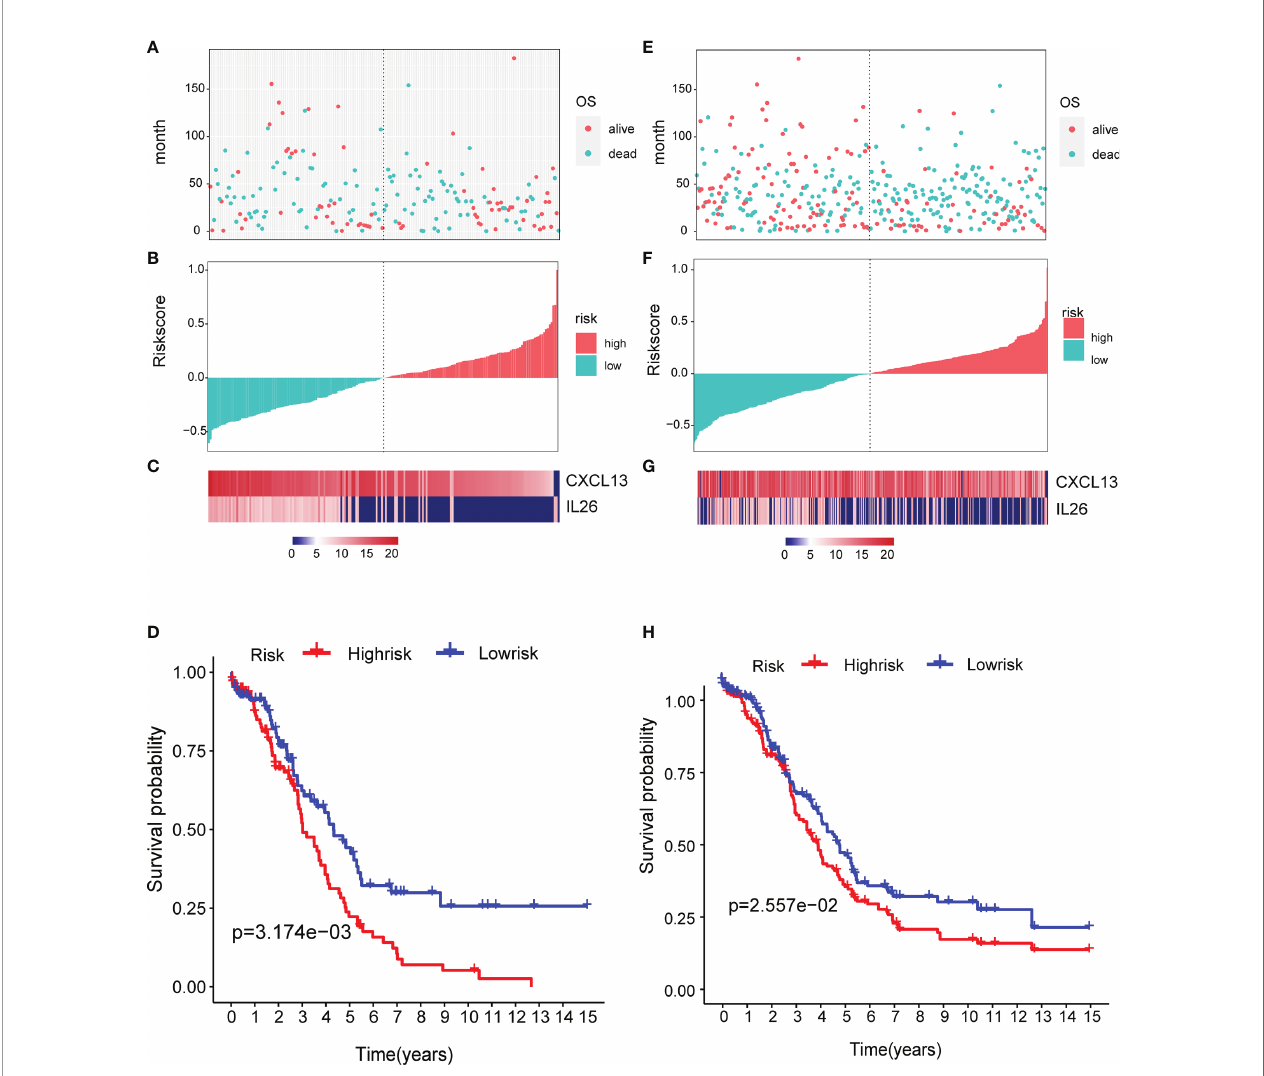
FIGURE 8 | Veri fi cation of the prognostic risk model: (A – C) the TCGA test and (E – G) all TCGA datasets were used to calculate the RiskScore and distribution, showing that samples with a high RiskScore were signi fi cantly smaller than those with a low RiskScore. (D, H) The results of the KM curves shown in reveal signi fi cant differences between the low and high-risk